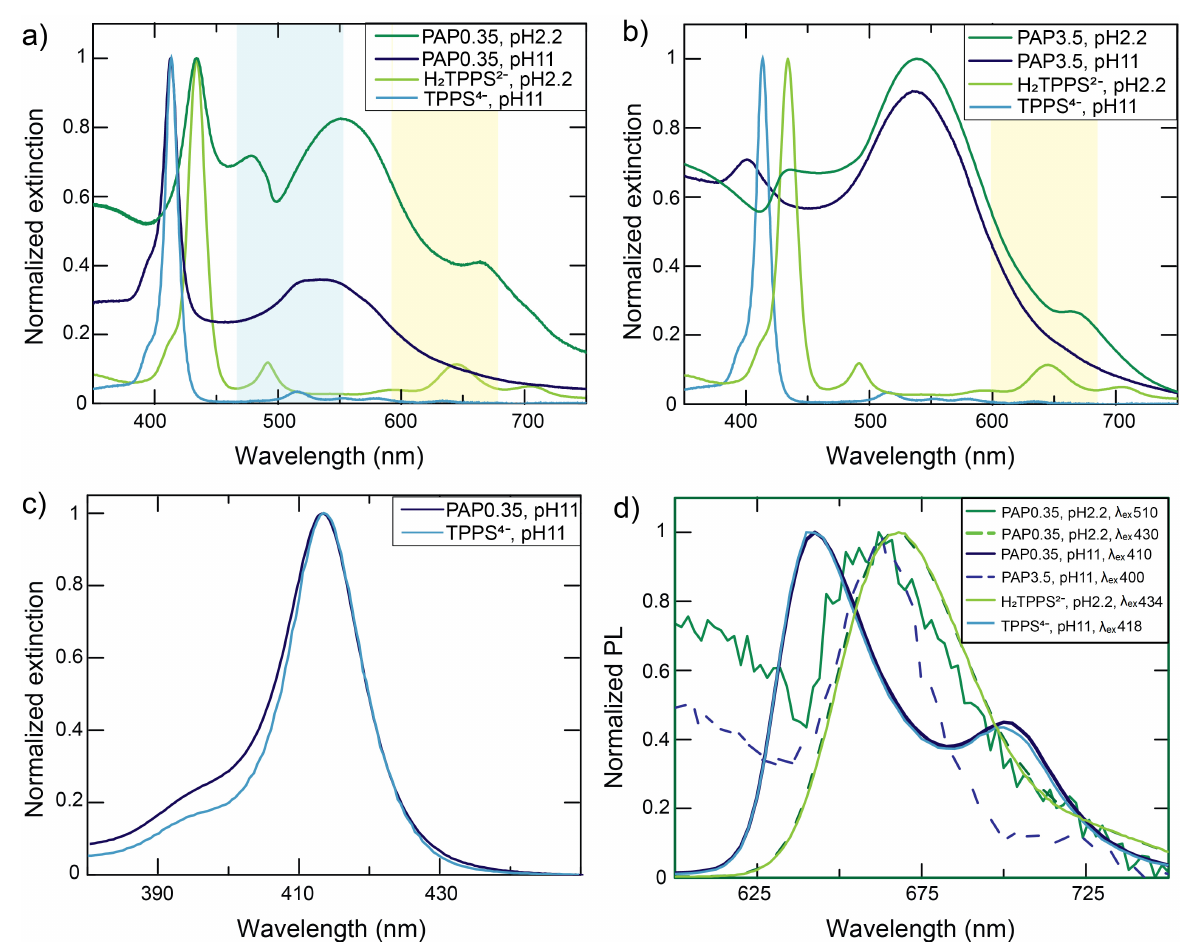
Figure 2. Overall perspective of the extinction and emission spectra of BNPs. ( a ) Extinction spectra of the hybrids at PAP = 0.35 nm 2 . H 2 TPPS 2 − and TPPS 4 − absorption spectra at pH 11 and 2.2, respectively, are reported as references. ( b ) Same as ( a ) but for PAP = 3.5 nm 2 . The blue (yellow) area highlights the presence of B (Q) plexciton resonances. ( c ) Comparison between the normalized extinction spectra of TPPS 4 − and BNPs at PAP = 0.35 nm 2 and at pH = 11. A constant baseline subtraction has been performed to ease the comparison. The TPPS 4 − absorption spectrum is reported as a reference. ( d ) Normalized emission spectra of nanohybrids in different conditions compared with the emission spectra of H 2 TPPS 2 − (pH = 2.2) and TPPS 4 − (pH = 11). The excitation wavelengths are reported in